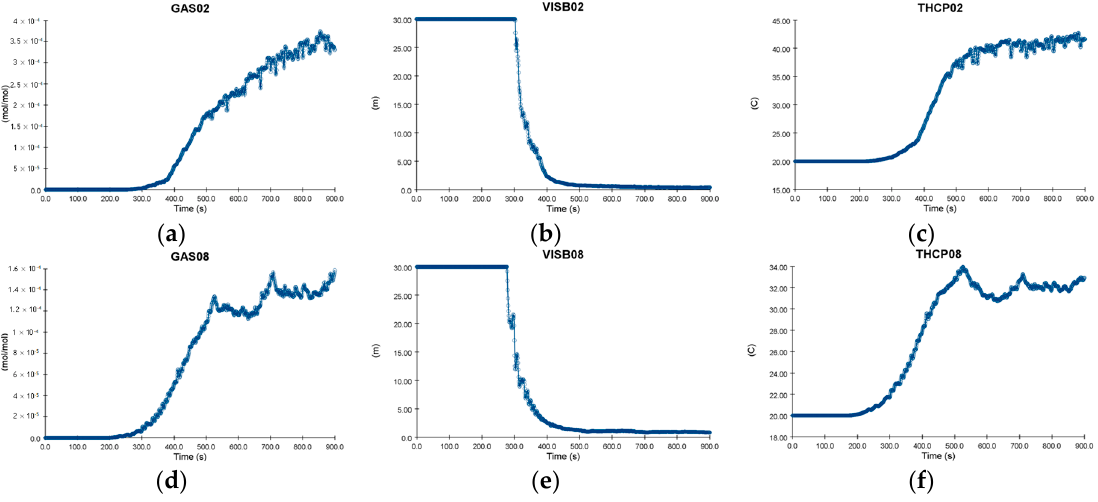
Figure 15. Change curves of fi re characteristics under working condition B: ( a – c ): left transverse passageway; ( d – f ): right transverse passageway.